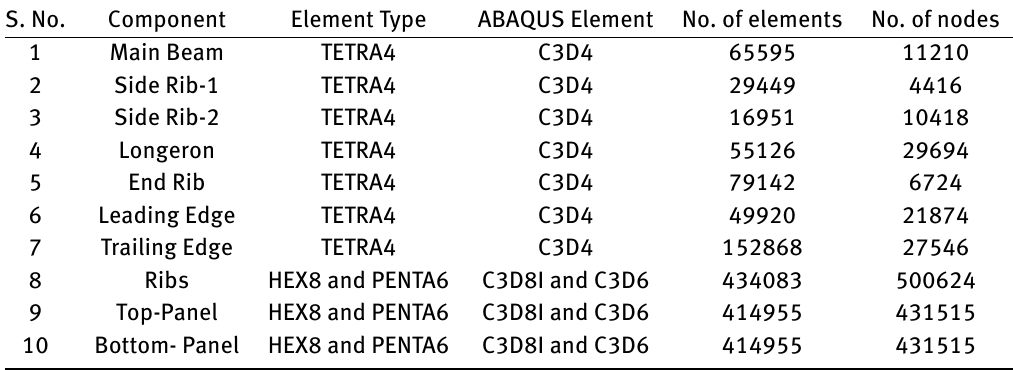
Table 3: Element and Node Details of Finite Element Model of Canard in ABAQUS S. No.